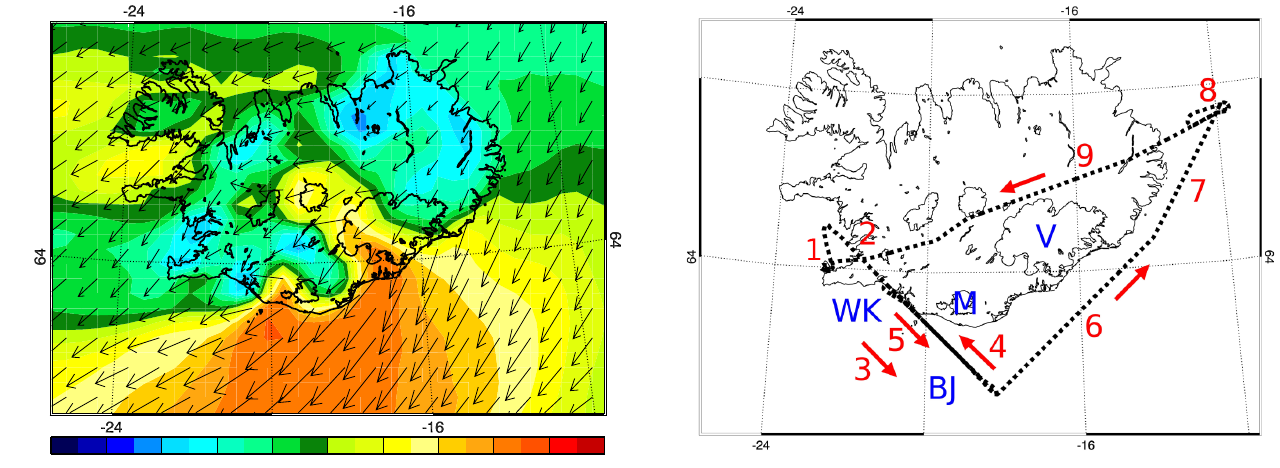
Fig. 2. Aircraft track (dotted line) for flight B269 of the GFDex campaign. The red numbers correspond to different flight legs: (1) take-off, (2) ascending, (3) at 1900m, (4) at 700m, (5) at 400m, (6) ascending, (7–9) at 7600m. The location of the wake, barrier jet, Mýrdalsjökull glacier and Vatnajökull glacier are indicated by WK, BJ, M and V respectively. The glaciers are also shown by land